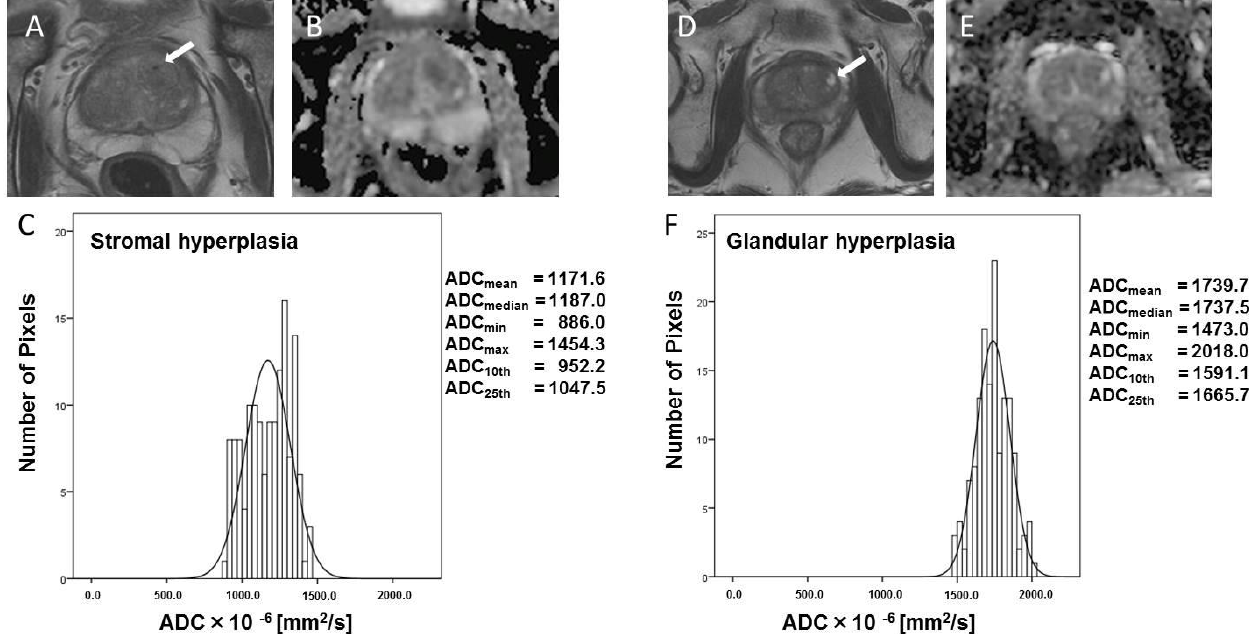
Figure 2. Typical histogram of BPH, and T 2 W and ADC images (stromal hyperplasia and glandular hyperplasia). Typical T 2 W images ( A , D ), ADC images ( B , E ), and ADC-derived histograms ( C , F ) for BPH. The ADC values of the SH foci reflect restricted diffusion in the ADC map (( B ), ADC mean = 1171.6 × 10 −6 mm 2 /s). In contrast, the ADC values of the GH foci are seen as bright regions on the ADC map (( E ), ADC mean = 1739.7 × 10 −6 mm 2 /s) and do not reflect restricted diffusion. The six histogram-derived ADC parameters are shown for each type of BPH. White arrows indicated BPH.